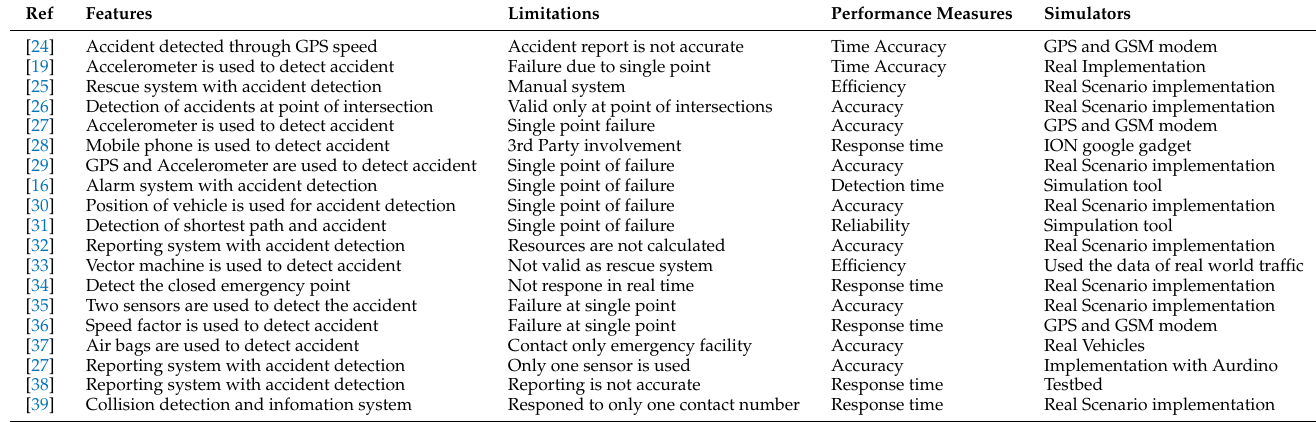
Table 1. Review of existing schemes